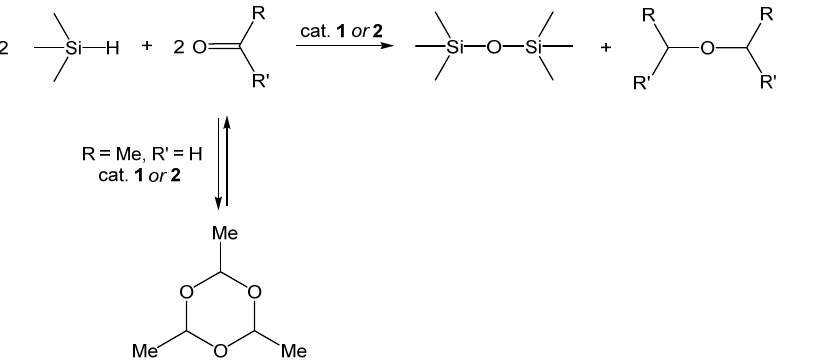
Table 5. Oxidative coupling of hydridosil(ox)anes (Si ‐ H) by aldehydes and ketones (C=O) and sim ‐ ultaneous reductive coupling to ethers in the presence of catalysts 1 and 2 [30]. Entries 1 ‐ 9 performed at room temperature, entries 10–19 at 50